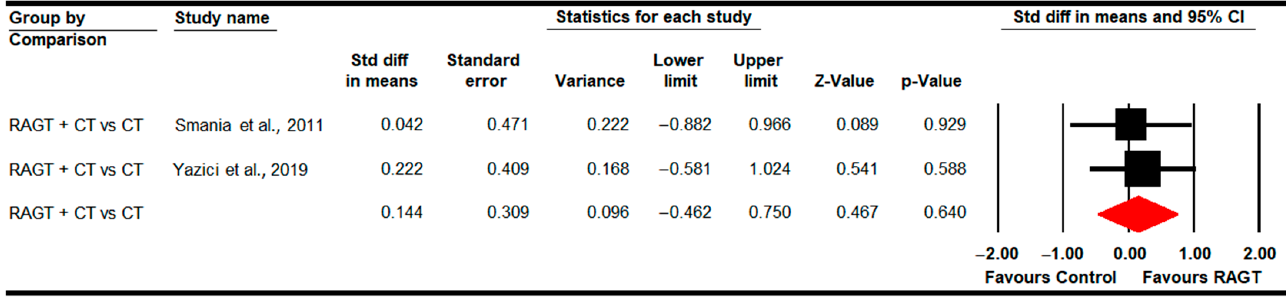
Figure 11. Forest Plot of Functional Independence (Post-Intervention Assessment) [80,84].